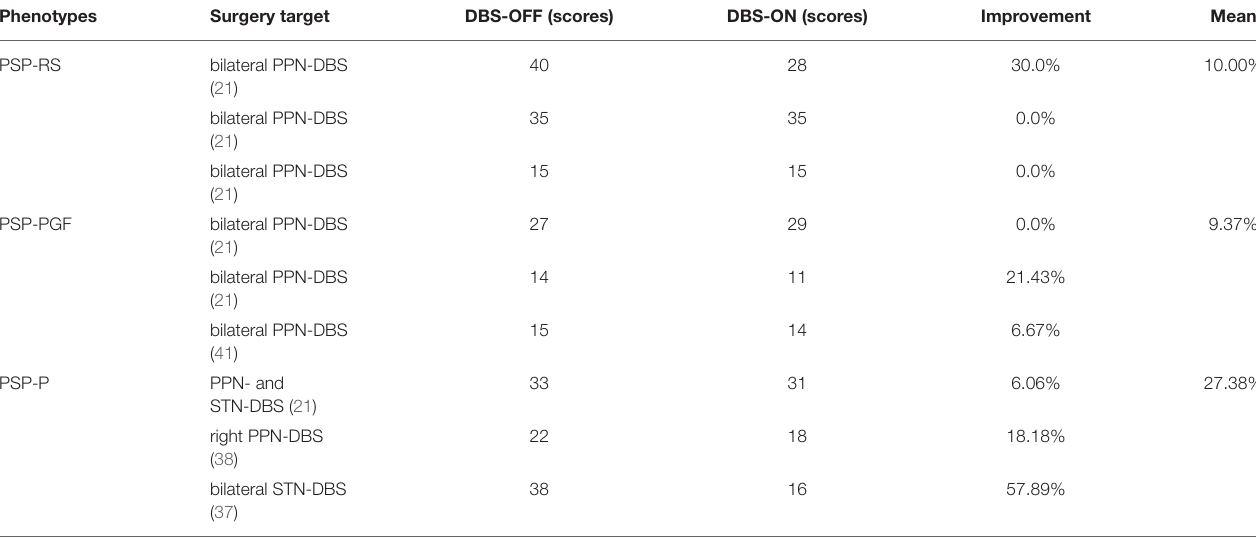
TABLE 3 | The effectiveness of PPN-DBS for PSP patients. Stimulation